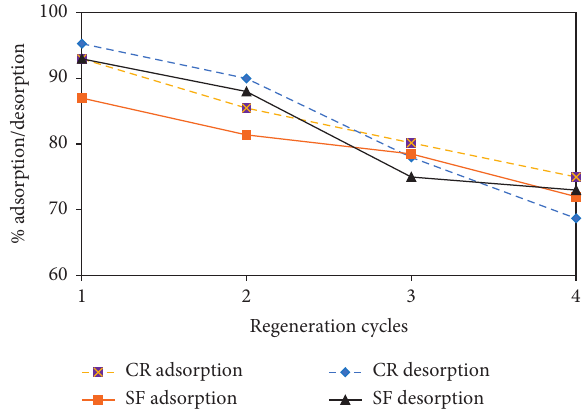
Figure 11: Regeneration cycles of CR and SF dyes on